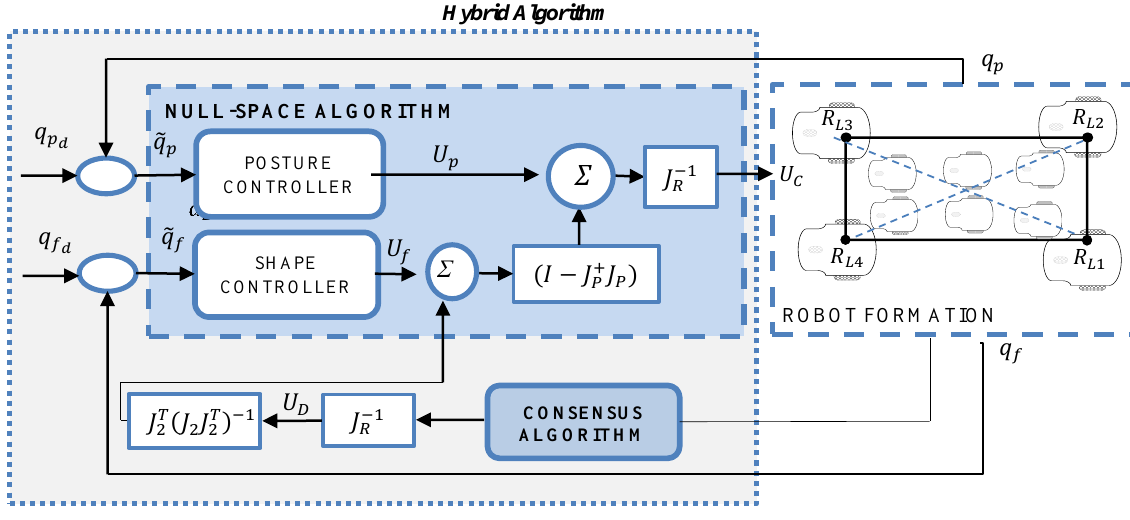
Figure 6. Hybrid algorithm (consensus and null-space)